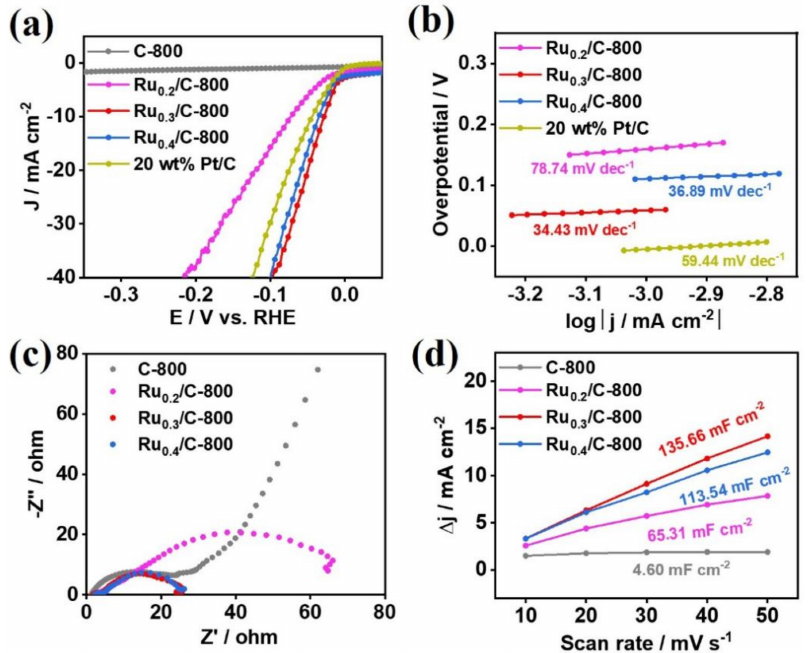
Figure 4. ( a ) LSV curves of C − 800, Ru 0.2 /C − 800, Ru 0.3 /C − 800, Ru 0.4 /C − 800, and 20 wt% Pt/C in 1.0 M KOH; ( b ) Tafel plots of C − 800, Ru 0.2 /C − 800, Ru 0.3 /C − 800, Ru 0.4 /C − 800, and 20 wt% Pt/C in 1.0 M KOH; ( c ) Nyquist plots of C − 800, Ru 0.2 /C − 800, Ru 0.3 /C − 800 and Ru 0.4 /C − 800 in 1.0 M KOH; ( d ) linear plot of the capacitive current against the scan rate for the estimation of C dl